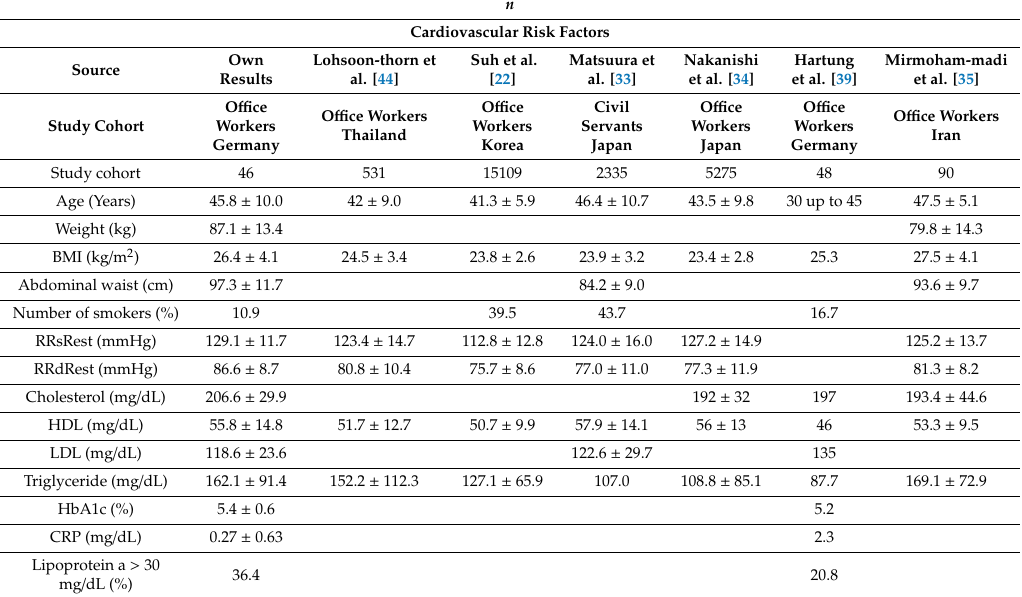
Table 7. Comparison of cardiovascular risk factors in published studies of o ffi ce workers and civil